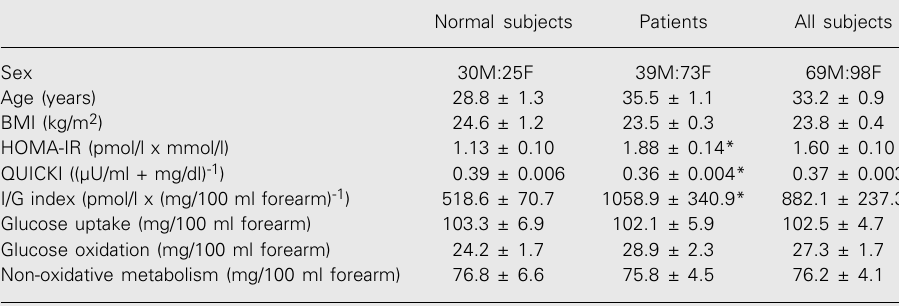
Table 1. Comparison of homeostasis model assessment (HOMA) and quantitative insulin sensitivity check index (QUICKI) with data from forearm metabolic studies for the assessment of in vivo insulin